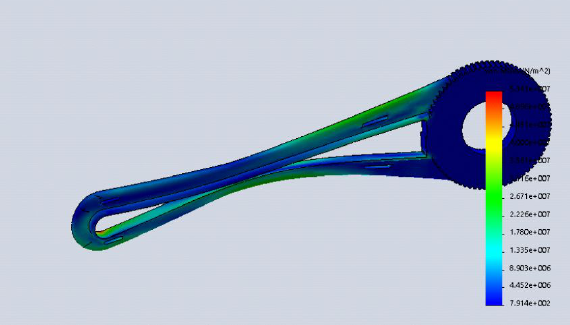
Figure 8: Second design prepared and simulated for the lower arm